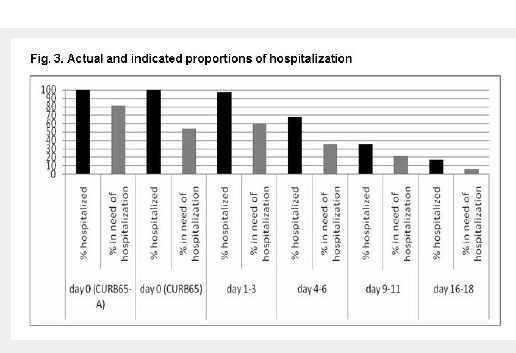
Length of stay according to CURB65 and CURB65-A. Figure 2a Total length of stay according to CURB65 and CURB65-A. Figure 2b Length of stay before medical stability according to CURB65 and CURB65-A. Figure 2c Length of stay after medical stability according to CURB65 and CURB65-A. Length of stay (2a. total length of stay, 2b. before medical stabilization was reached, 2c. after medical stabilization was reached) stratified for risk score according to CURB65 and CURB65-A.